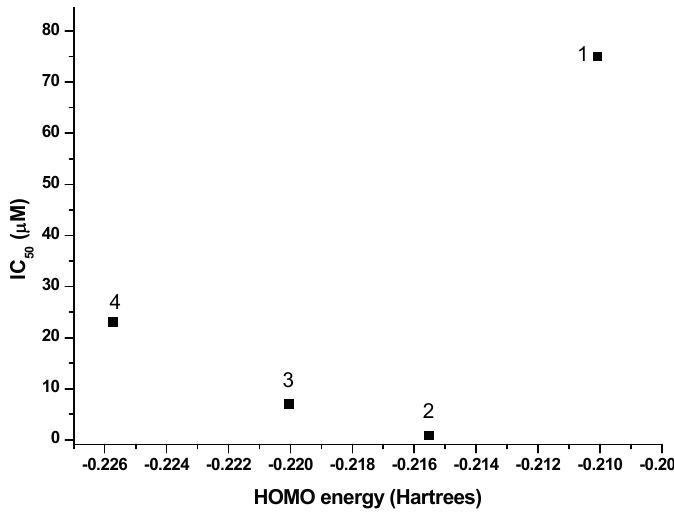
Figure 7. HOMO orbital energy effect over the amoebicidal activity (IC 50 ) of nitrobenzene hydrazone